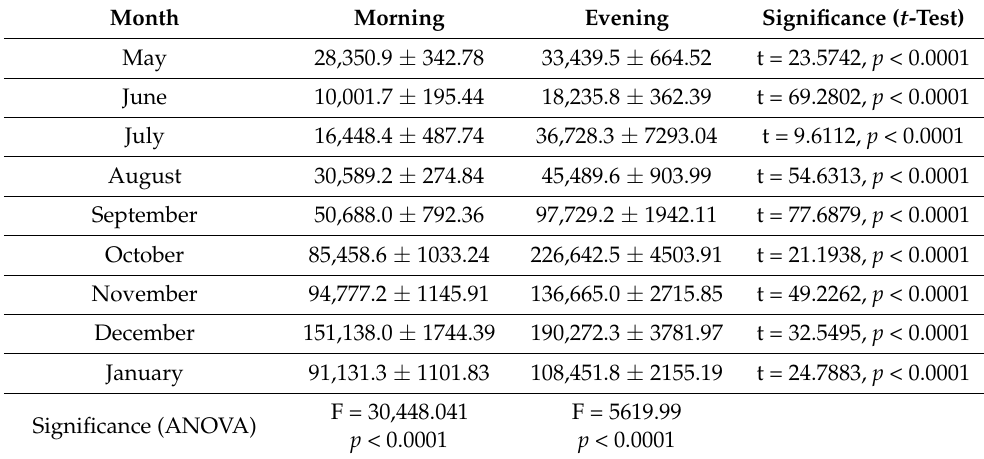
Table 3. Seasonal variation of the mean values of the alkaline phosphatase activity in goat’s milk.